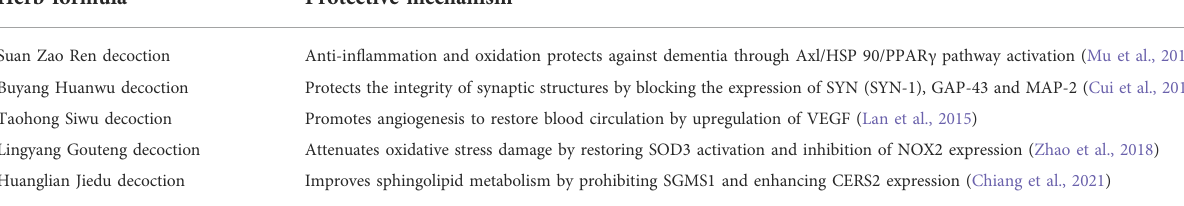
TABLE 1 Herbal formulas that exert protective effects against